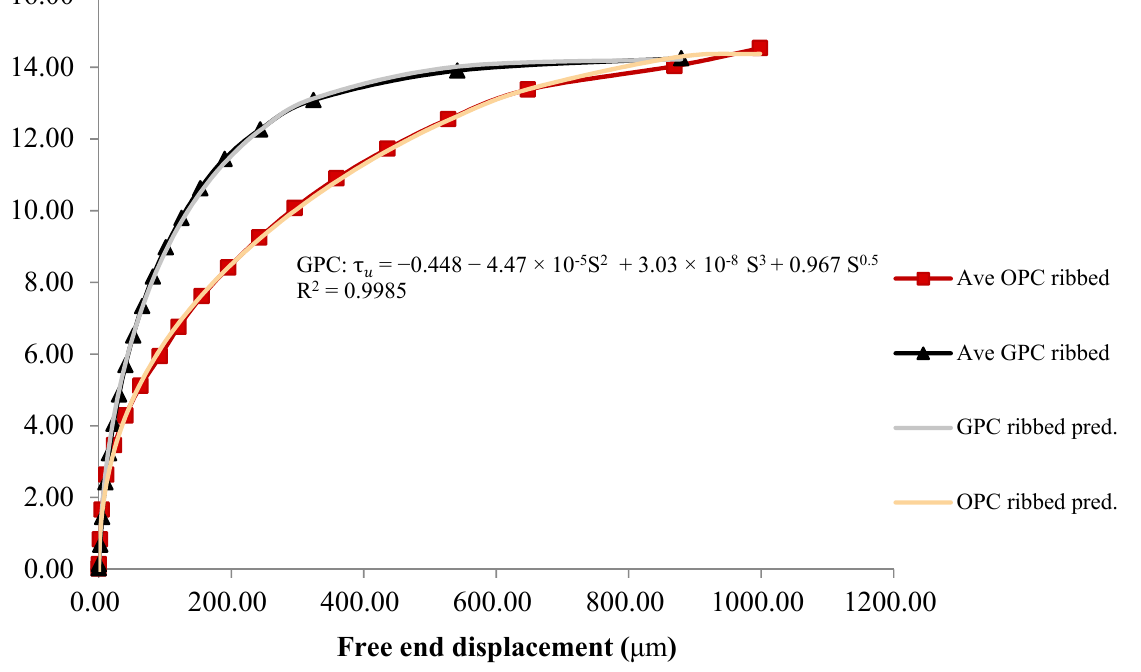
Figure 17. Statistical regression model of the bond–slip relationship between the ribbed bar and GPC. The iteration algorithm utilized in the regression was the Levenberg–Marquardt